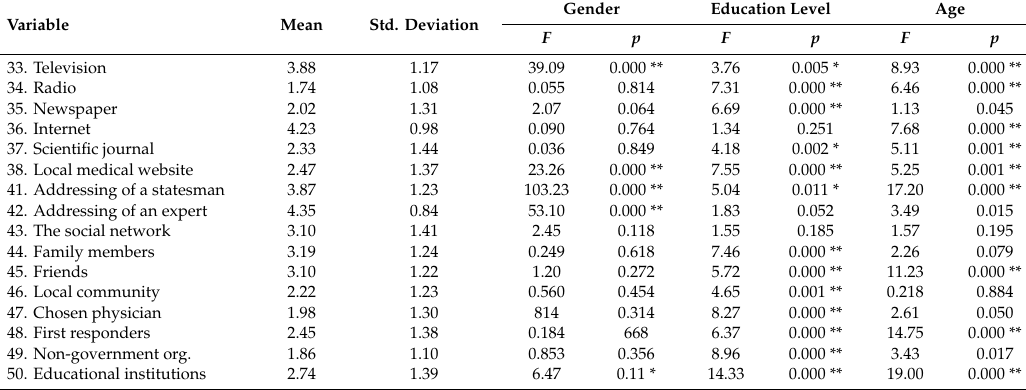
Table 5. One-way ANOVA results of information sources of citizens and gender, education level, and age the variables on the risk perception of coronavirus disease. Variable Mean Std.